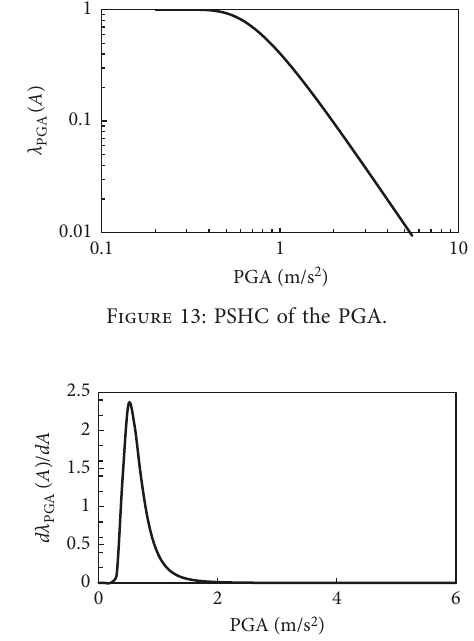
Figure 14: Probability distribution of